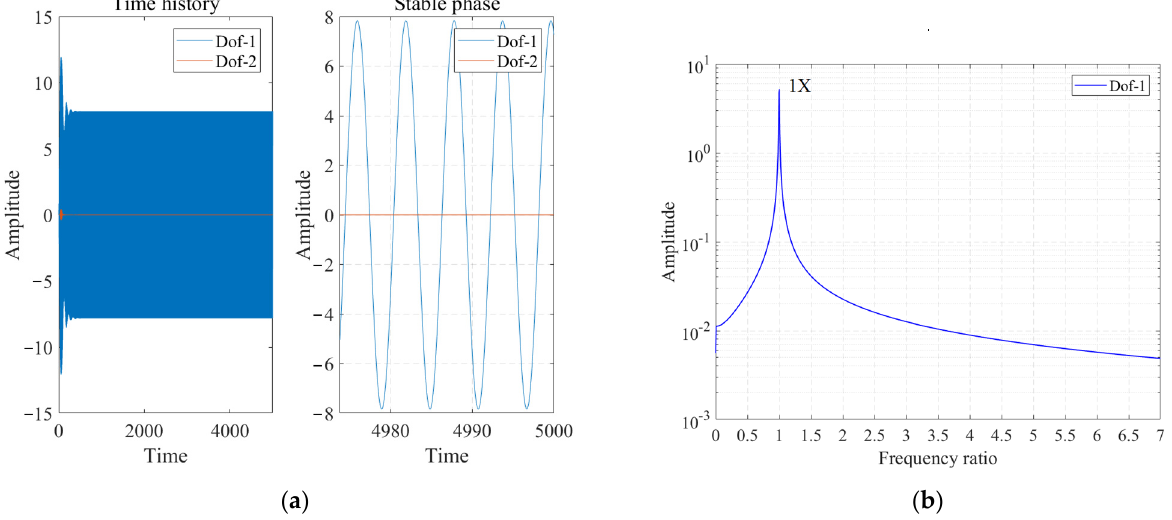
Figure 11. Time history and frequency spectra of the system with an excitation frequency of 1.06 (initial displacement is [0, 0], the initial velocity is [0, 0]): ( a ) time history; ( b ) frequency spectrum.